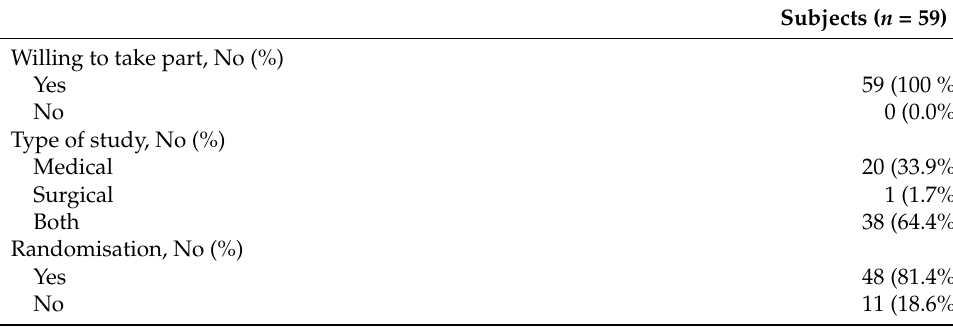
Table 3. Inclination to take part in research